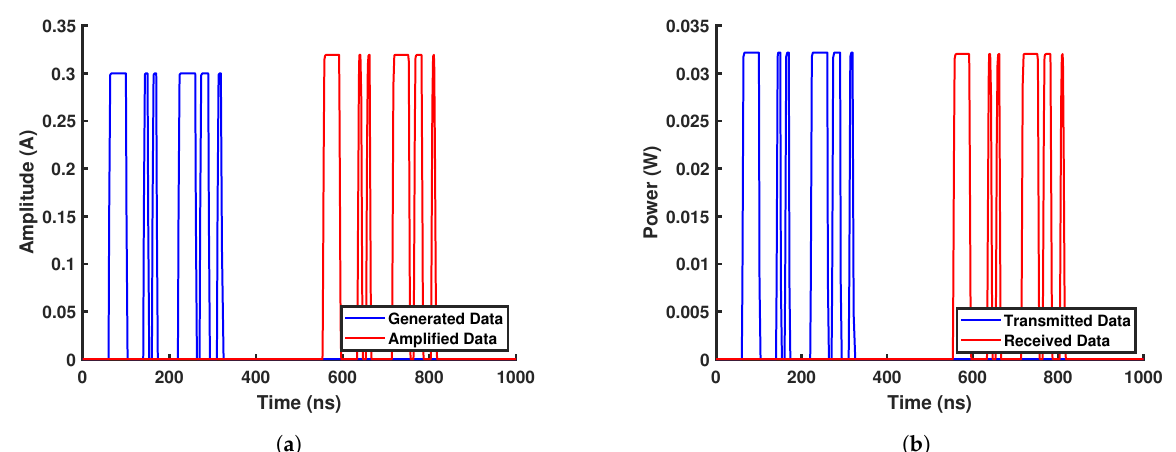
Figure 11. The total time elapsed in sending 32 bits to the input port of the RTU. ( a ) 32 generated bits vs the received amplified data. ( b ) Propagation delay in the fiber cable.